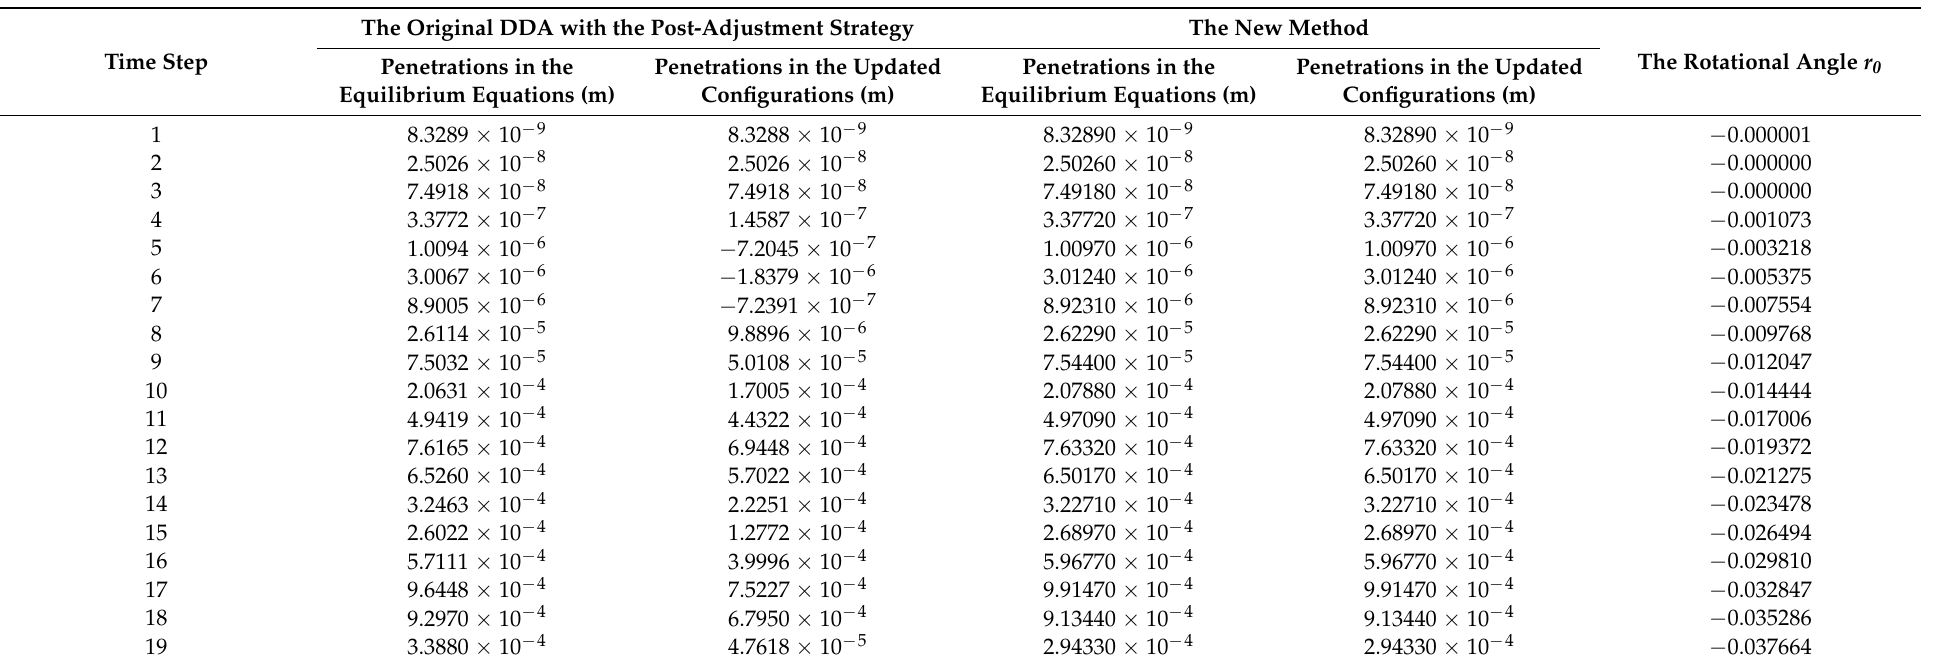
Table 1. The penetrations of the contact pair point 7–edge 14 by DDA with the post-adjustment strategy and the new